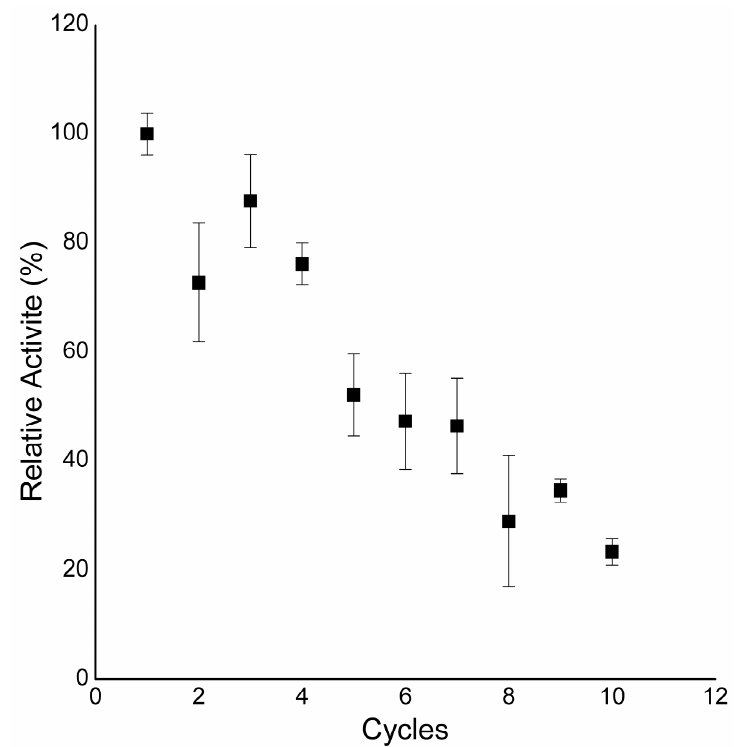
Figure 7. Relative activity of immobilized ALDC in the conversion of α -acetolactate to acetoin. Error bars represent the standard deviation from the mean of three independent experiments.